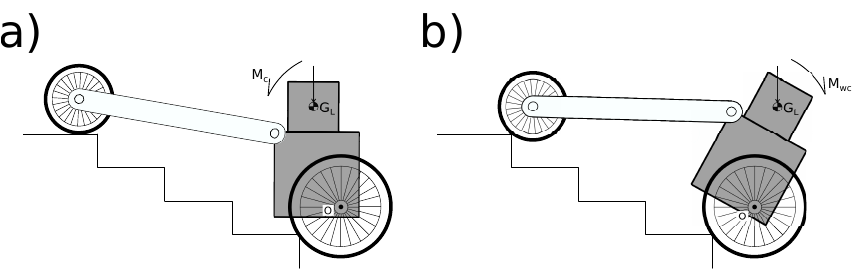
Figure 23. Robot schematic while descending; ( a ) with control; ( b ) without